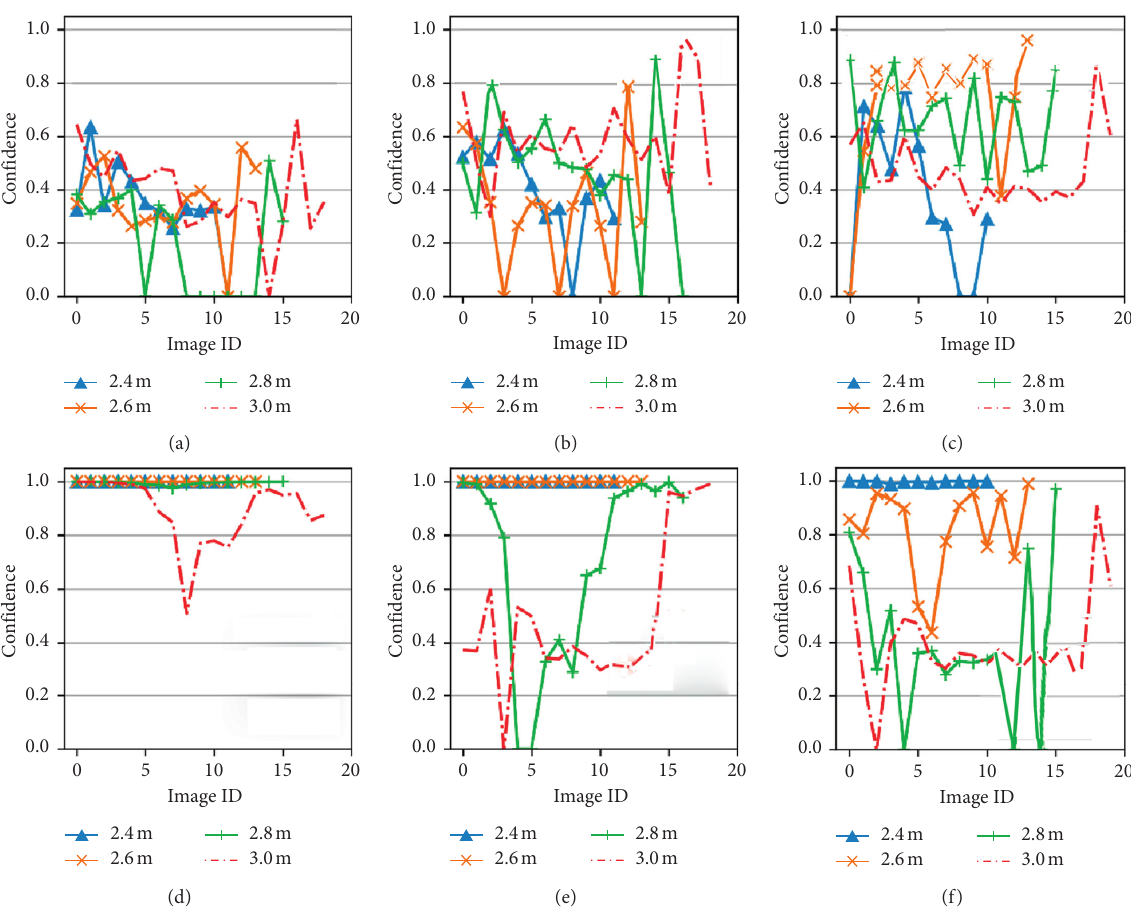
Figure 9: Detection confidences at different standard DDs and heights. (a) ROI_O, DD: +5%. (b) ROI_O, DD: 0%. (c) ROI_O, DD: − 5%.